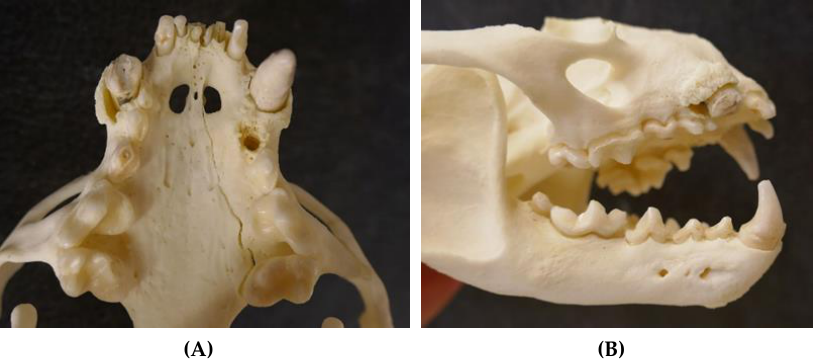
Figure 5. Severely worn-down teeth of an adult male otter (5.5–7.5 years) from Schleswig-Holstein; some teeth are even missing (( A ) ventral view upper jaw and ( B ) lateral view skull).